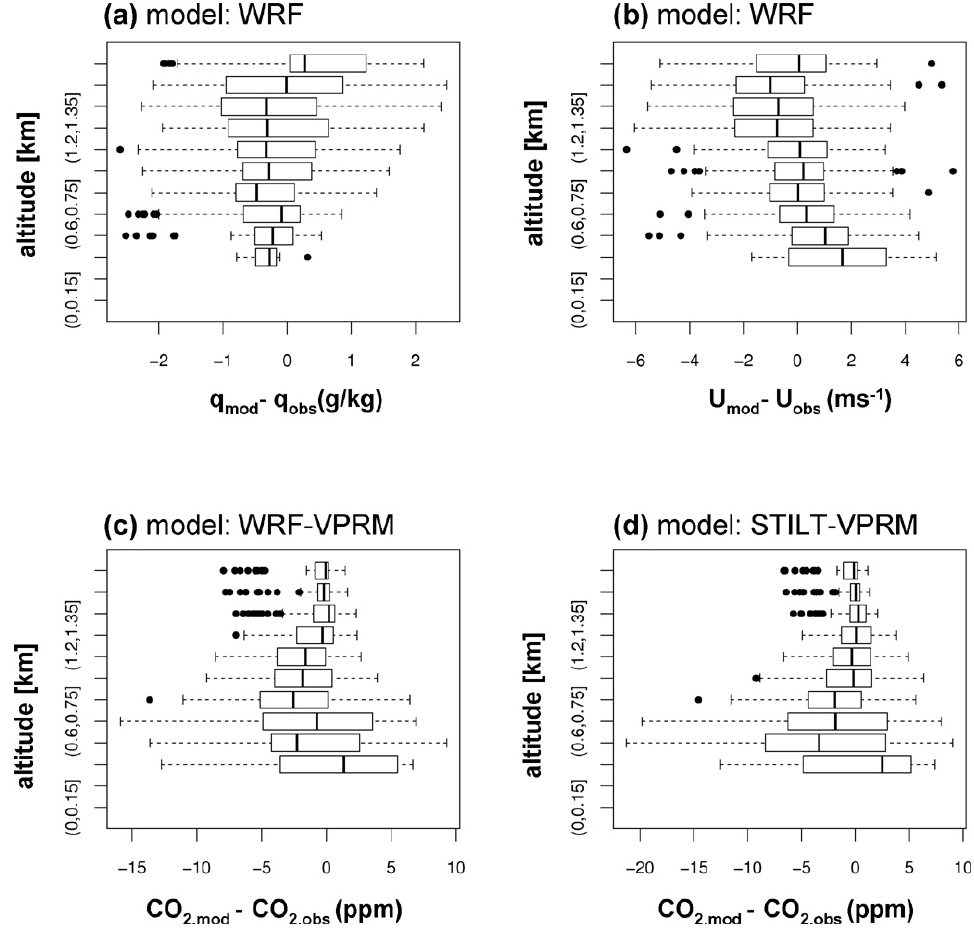
Fig. 4. The box-whisker plot of model mismatch (simulations-observations) using all aircraft profiles for (a) specific humidity, (b) wind speed and (c) CO 2 (WRF-VPRM) (d) CO 2 (STILT-VPRM).The box indicates 95% quartile, the whisker denotes minimum and maximum of deviations and the vertical bar inside the box denotes the median. Black dots are outliers. Table 1. Summary statistics of observed and simulated (WRF) meteorological fields (model bias (bias), standard deviation of the difference between the model and the data (sd) and squared correlation coefficient R 2 ) using hourly time series at available measurement levels for different seasons. The bias and sd are in SI units of respective meteorological